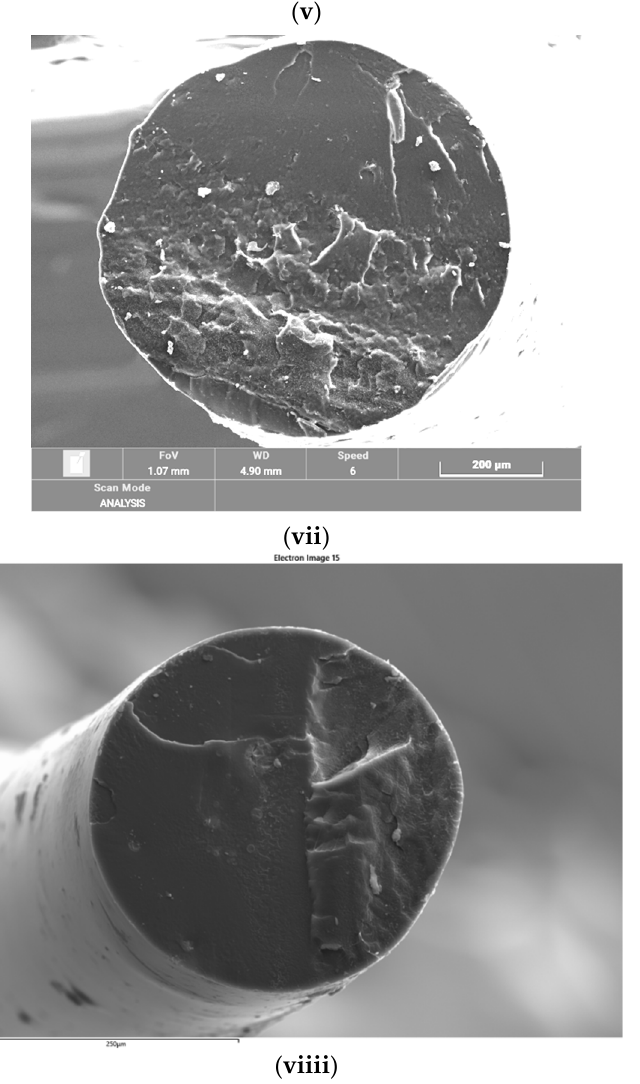
Figure 4. Morphology of LLDPE/MP fibres, 30 wt% LLDPE ( i , ii ); 60 wt% LLDPE ( iii , iv ); 70 wt% LLDPE ( v , vi ); 80 wt% LLDPE ( vii , viii ); and neat LLDPE ( viiii ).